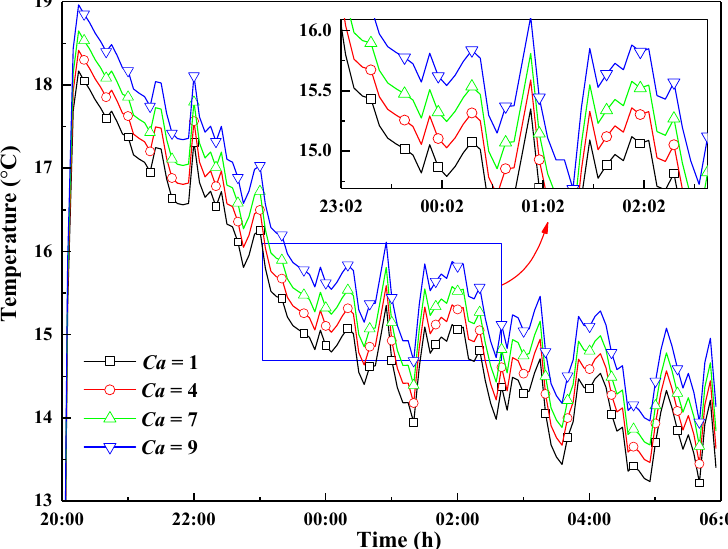
Figure 15. Time-dependent variation of the component surface temperature with different cloudiness coefficients.